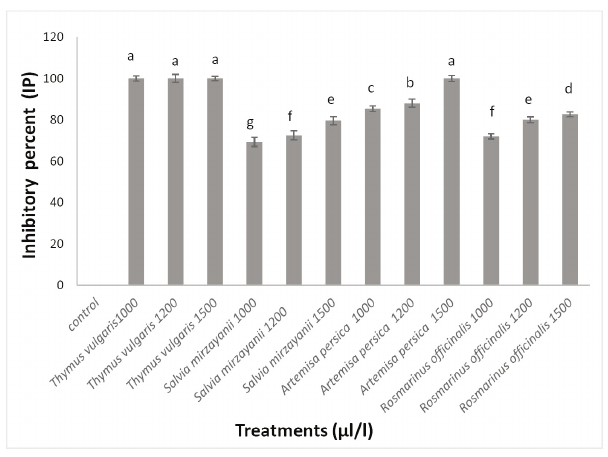
Fig. 1 - Inhibitory effect of the Thymus vulgaris , Salvia mirzaya- nii , Artemisia persica and Rosmarinus officinalis EOs tested at 1000, 1200 and 1500 μl/l on mycelia growth of Aspergillus niger cultures incubated at 25°C for 10 days. Bars indicate the SD of the mean. Different letters indica- te significant differences in mean values